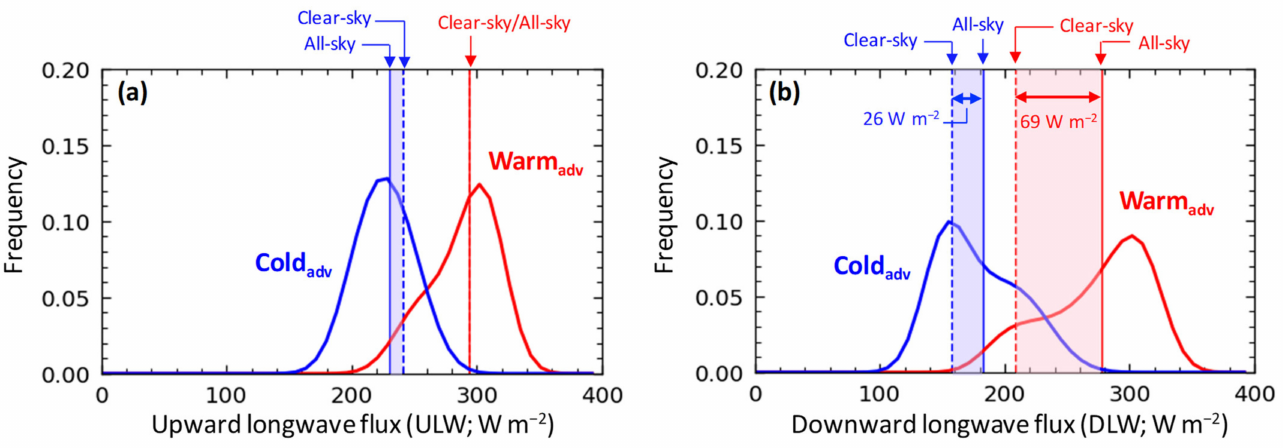
Figure 7. Frequency distributions of ( a ) ULW fluxes and ( b ) DLW fluxes under warm adv (red) and cold adv (blue) cases. Solid vertical line indicates the all-sky LW fluxes from ground-based BSRN radiometer measurements. Dashed vertical line indicates the modeled clear-sky LW fluxes calculated by radiative transfer model (SBDART) simulations using the mean profiles of temperature and humidity from radiosonde measurements. The differences of LW fluxes between all-sky and clear-sky conditions are shown by colored shading. In ( b ), shaded intervals indicate the increase in DLW fluxes compared to cloud-free conditions under each advection